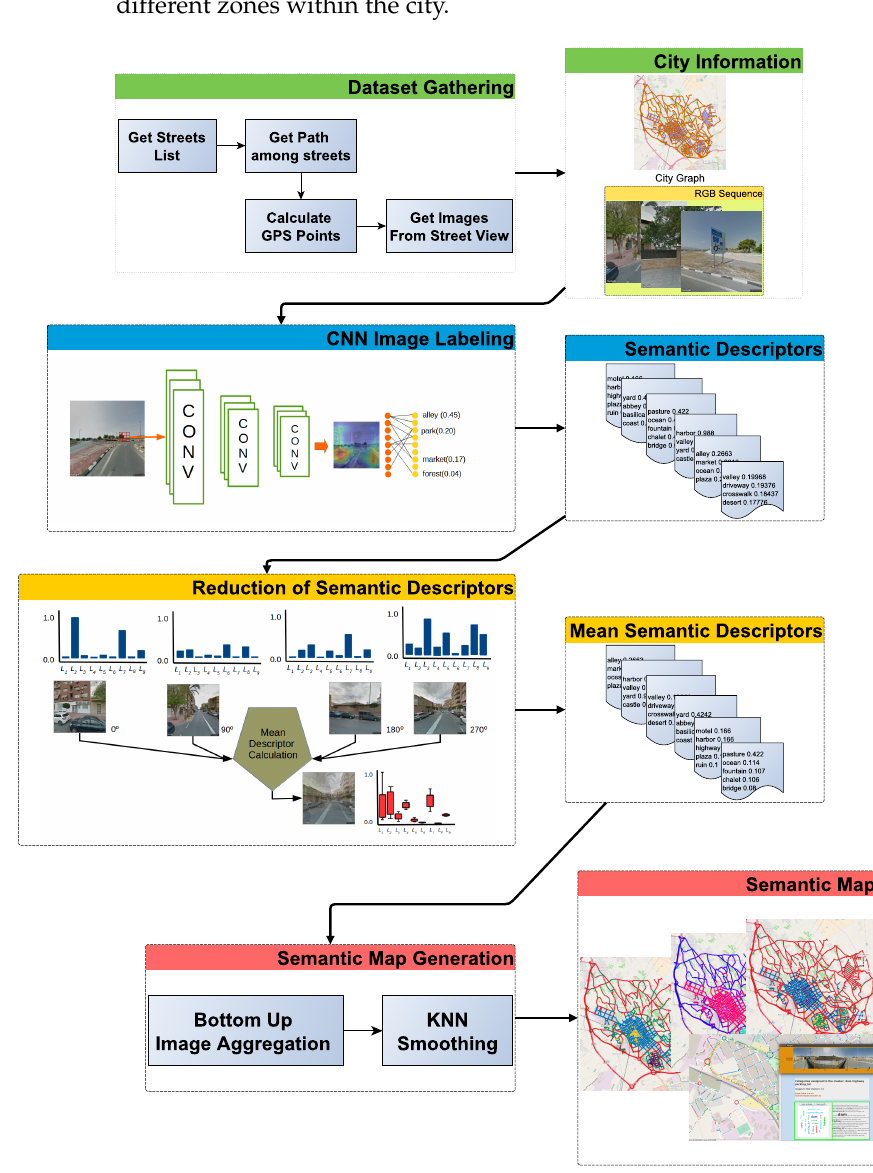
Figure 1. Proposal pipeline. This figure illustrates how the different procedures used in the proposal interact with the others and the output of each